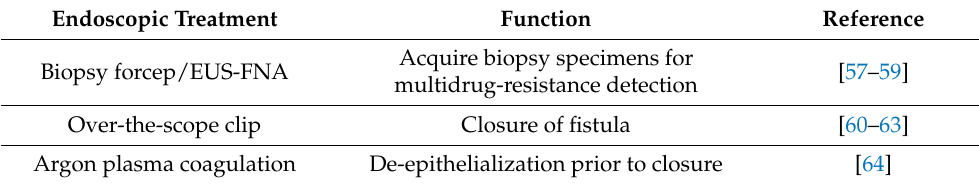
Table 4. Endoscopic treatment of esophageal